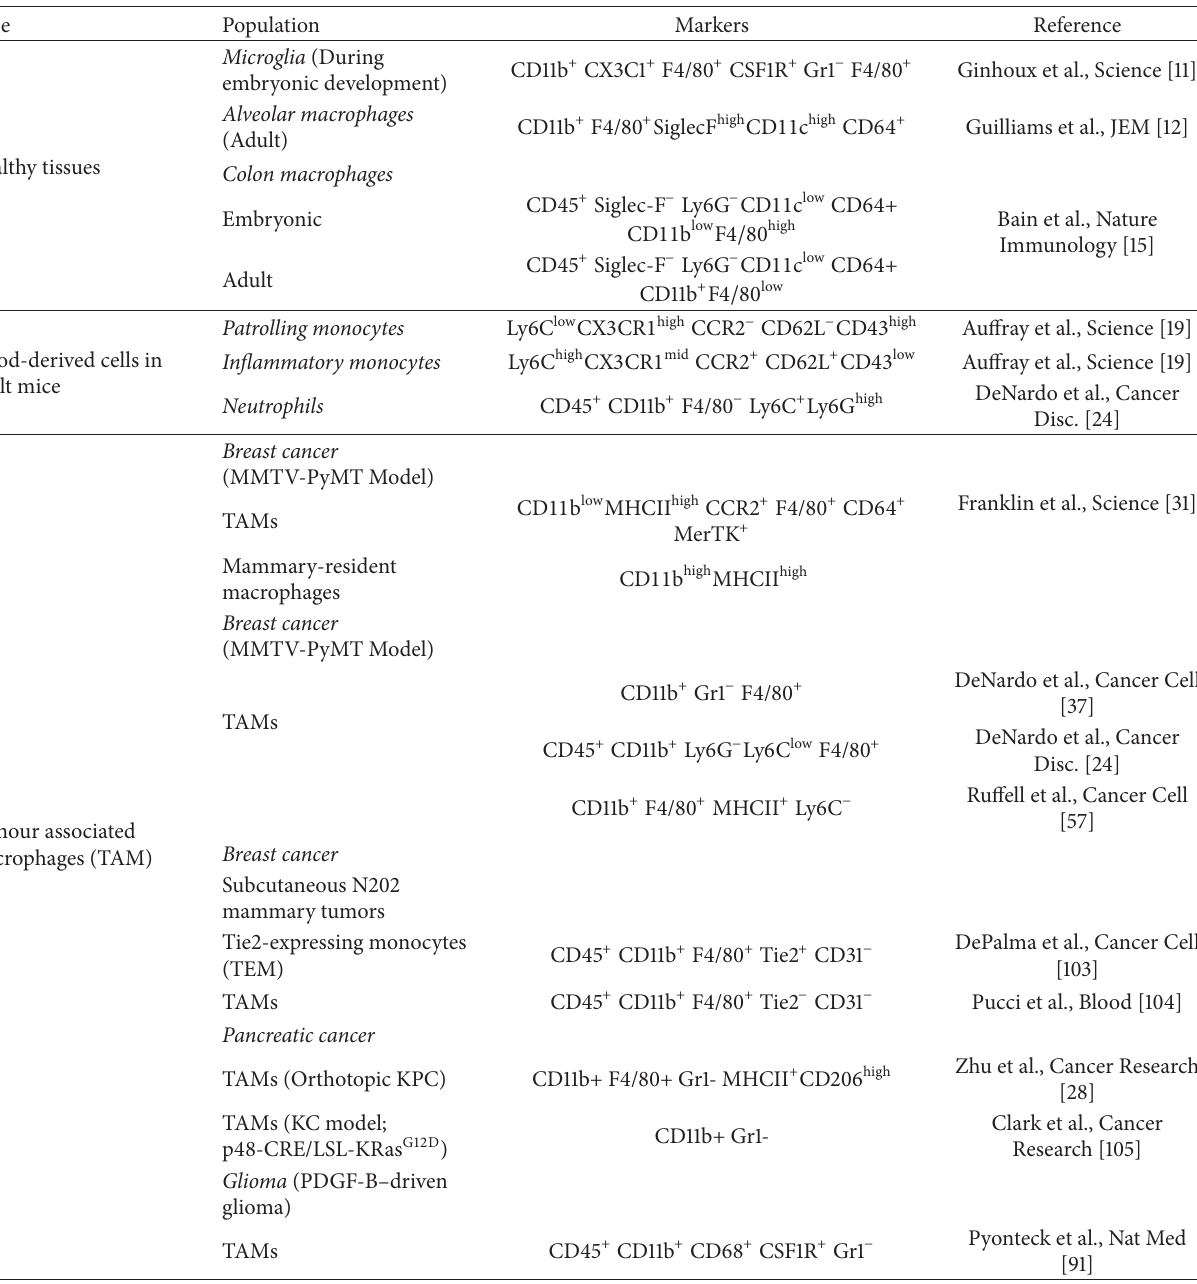
Table 1: Markers used to identify murine macrophage populations in healthy and tumour-bearing